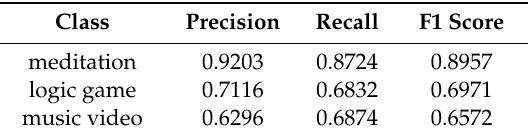
Table 26. Values of precision, recall, and F1 score for each class for NN with three hidden layers with the LeakyReLU activation function and the welch32 feature extraction scheme.